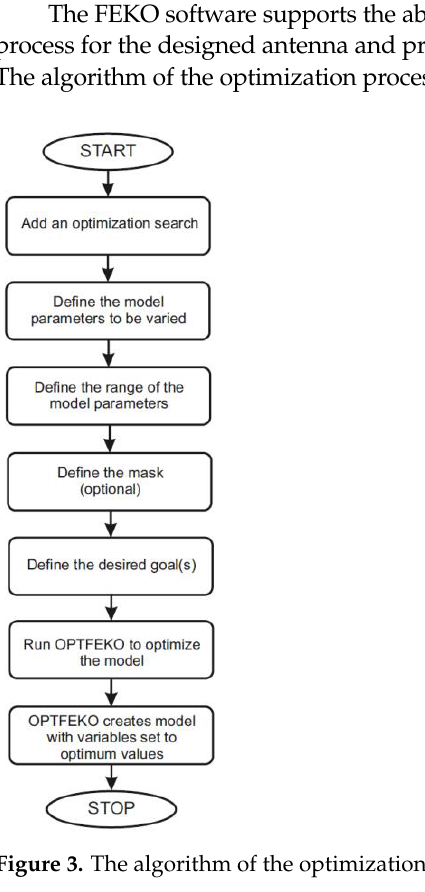
adjustment of accuracy levels required for the optimization process. Three